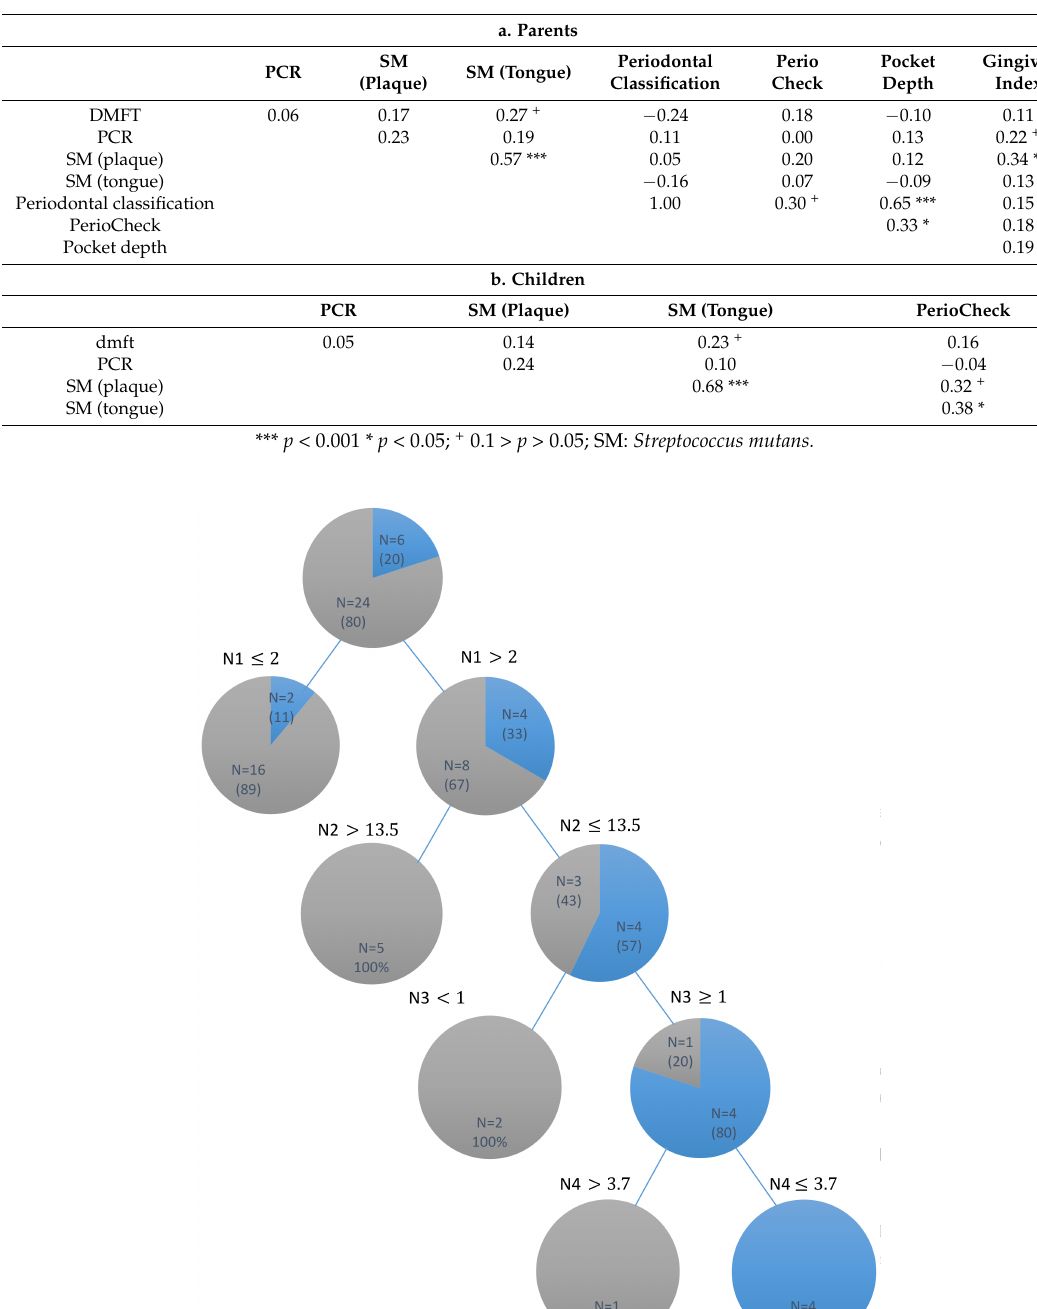
Table 3. Kendall rank correlation coefficient between periodontal status and caries index strata for parents and children.